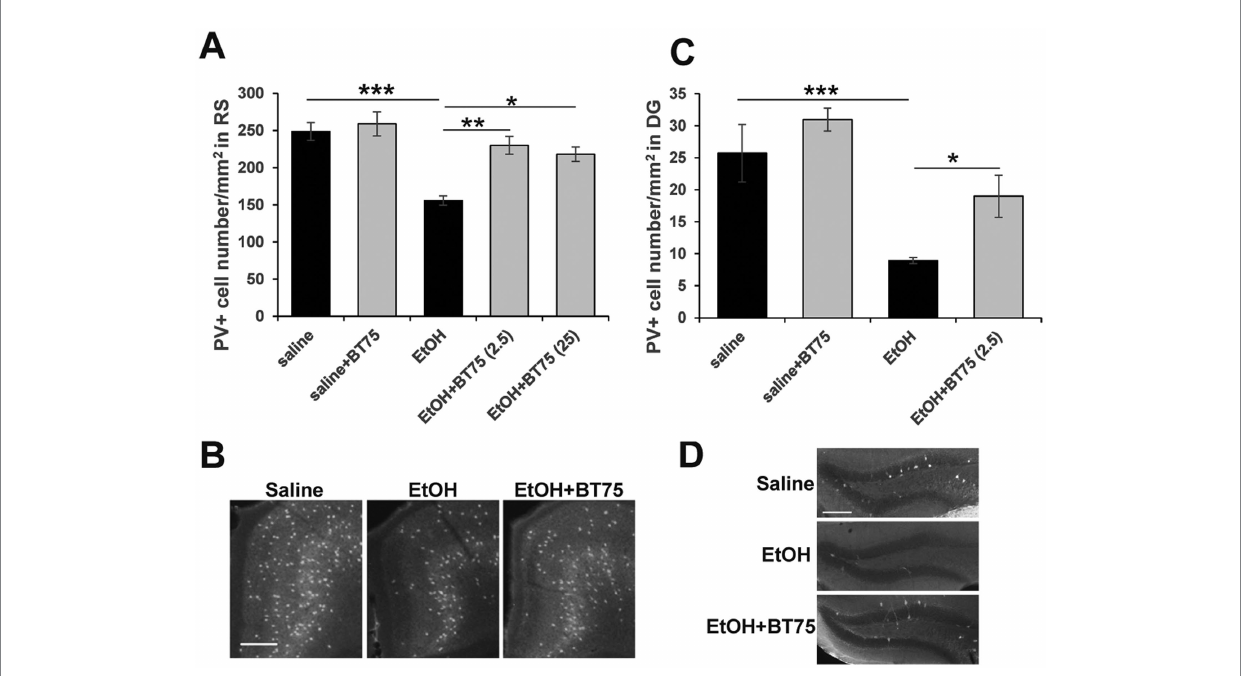
FIGURE 4 BT75 given before ethanol attenuates P7 ethanol-induced PV neuron deficits at P60. (A) 30 min before saline/EtOH administration, P7 mice were injected (icv) with 10% DMSO or BT75 (2.5 μ g or 25 μ g) and were perfusion-fixed at P60. Then, PV+ cell densities were counted in RS. *** p < 0.001, ** p < 0.01, and * p < 0.05 by a Tukey post-hoc test after one-way ANOVA. n = 4. (B) Representative images used in A . (C) PV+ cell densities were counted in DG. *** p < 0.001 and * p < 0.05 by a Fisher’s LSD post-hoc test after one-way ANOVA. n = 4. (D) Representative images used in C . In B and D , scale bar = 200 μ